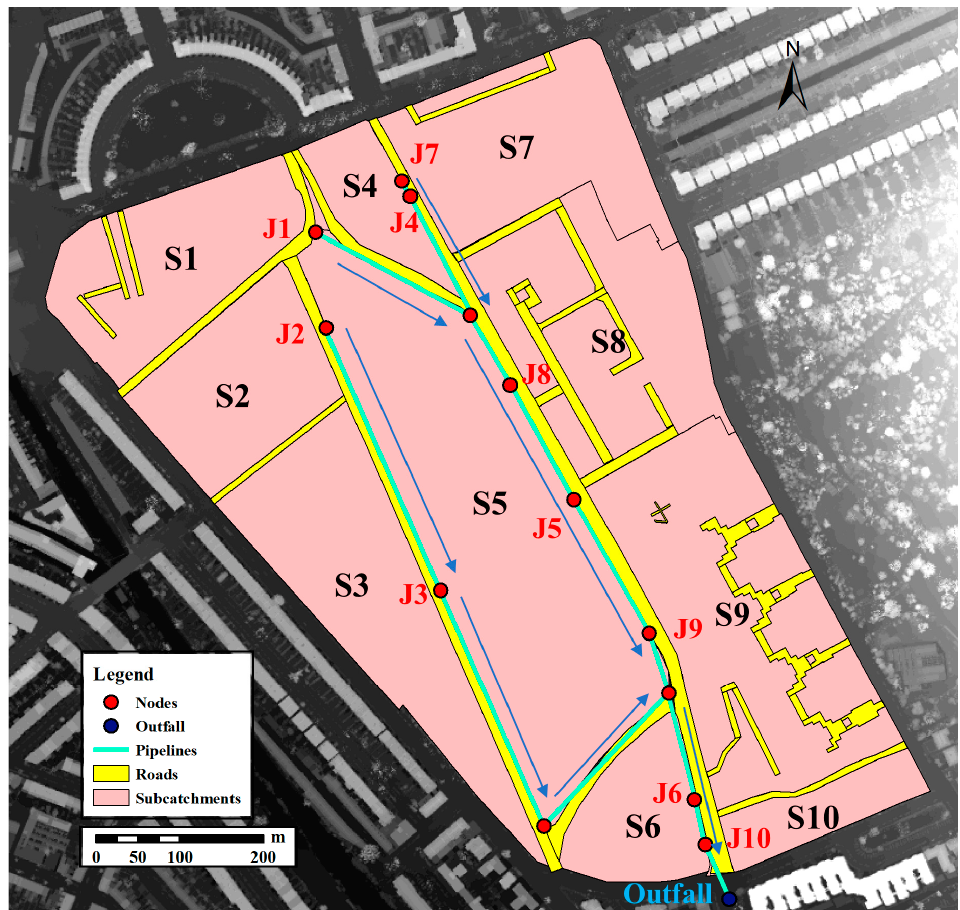
Figure 4. The subcatchments and drainage system in the study area: red points represent nodes; blue point represents outlet; thick solid blue lines represent pipelines; yellow polygons represent roads; pink polygons represent subcatchments; blue arrows represent flow direction in the pipe- lines.